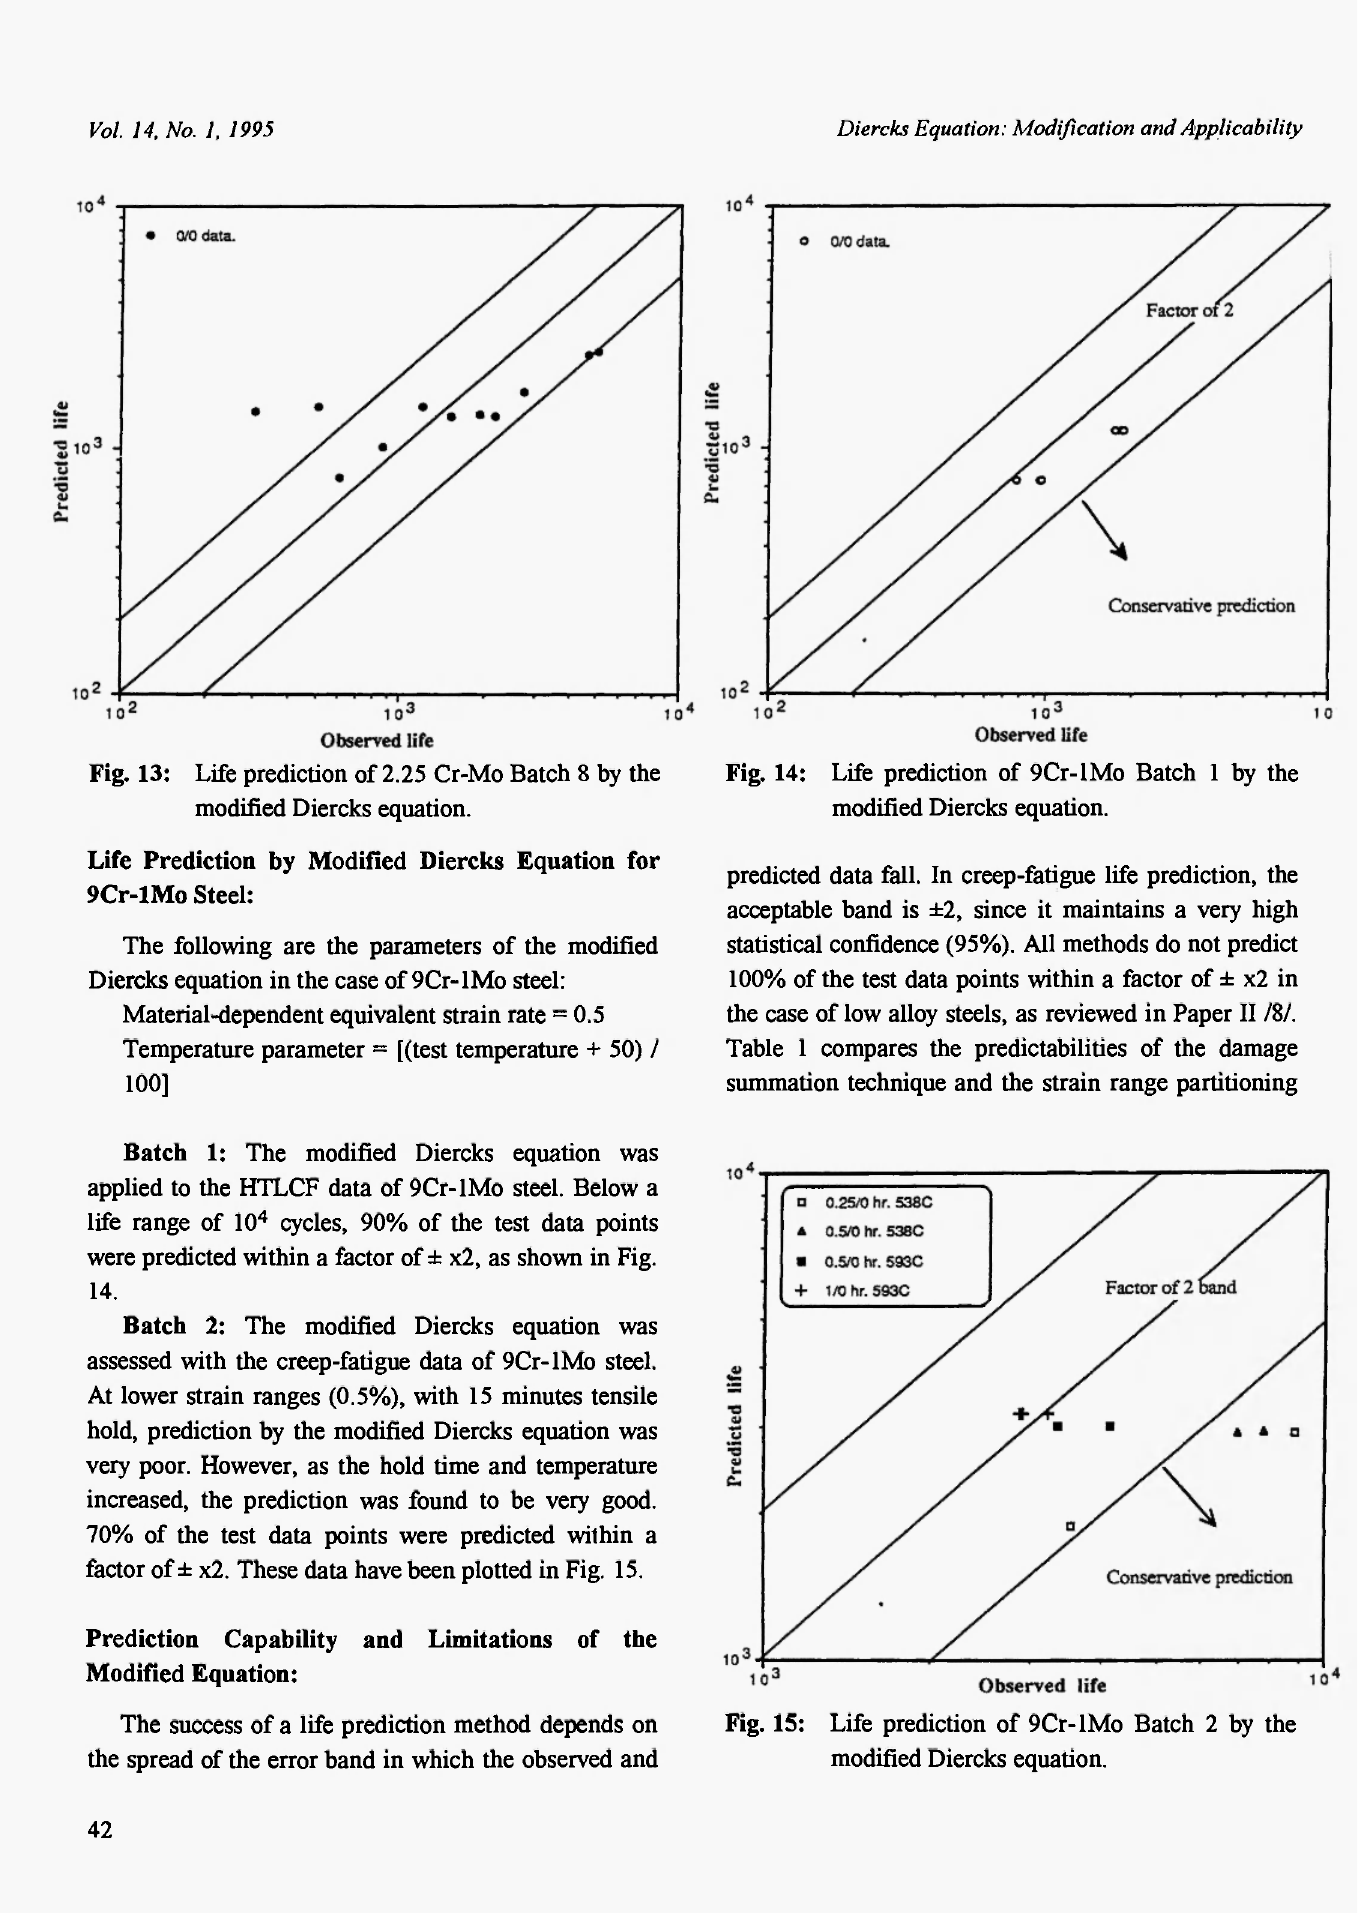
Fig. 15: Life prediction of 9Cr-lMo Batch 2 by the modified Diercks